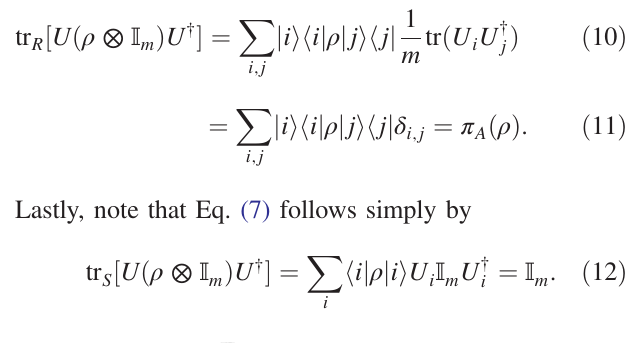
FIG. 1. Two possible ways of dephasing and the resulting correlation structure. Top: A sequence of systems in state ρ is dephased using a single state of randomness, with correlations being established between all systems involved. The local marginals of the resulting global state Eq. (13) are the dephased initial states. Bottom: In order to avoid correlations between the systems, one can instead use additional and unused